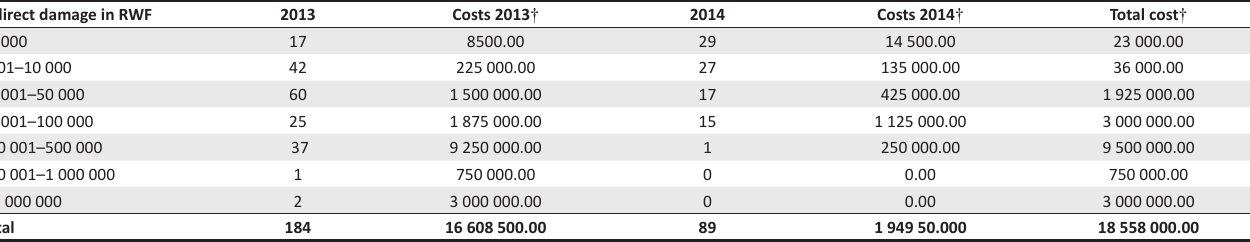
TABLE 5: Estimation of indirect damage costs based on the most severe event for each enterprise by year cross-analysed with estimated loss of profits during business closures after flooding (all amounts in Rwandan franc). Indirect damage in RWF